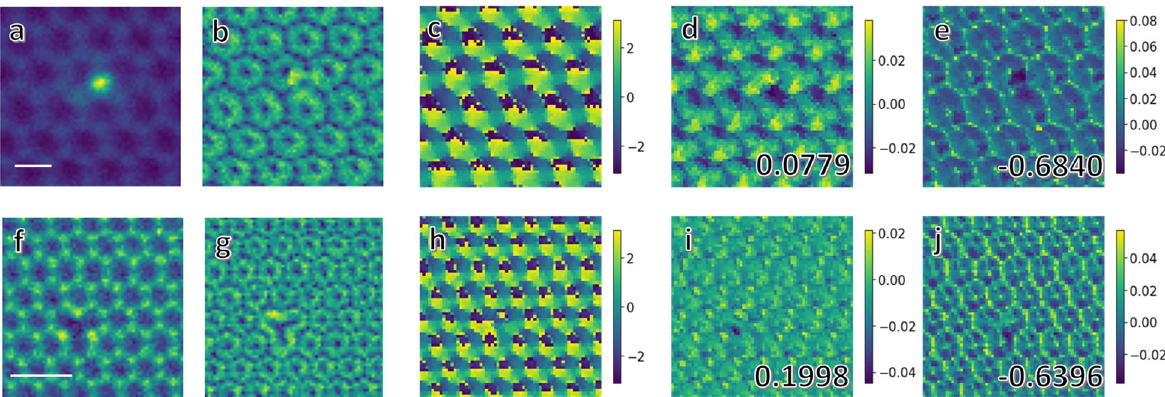
Fig. 6 Application to Experimental Graphene with defects. Graphene with a threefold Si impurity and 1 nm fi eld of view after 90 iterations. a The simultaneously acquired ADF image, b The magnitude of the COM, c the rotation map from rrVAE and d , e the two latent variable distributions. The scale bar on ( a ) is 2 Å. Graphene with a vacancy and 1.5 nm fi eld of view after 55 iterations. f The simultaneously acquired ADF image, g The magnitude of the COM, h the rotation map from rrVAE and i , j the two latent variable distributions. The scale bar on ( f ) is 5